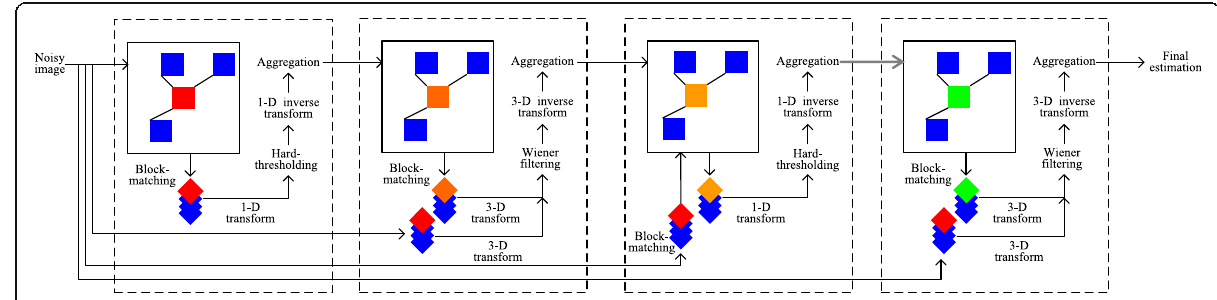
Fig. 4 The flowchart of the proposed algorithm